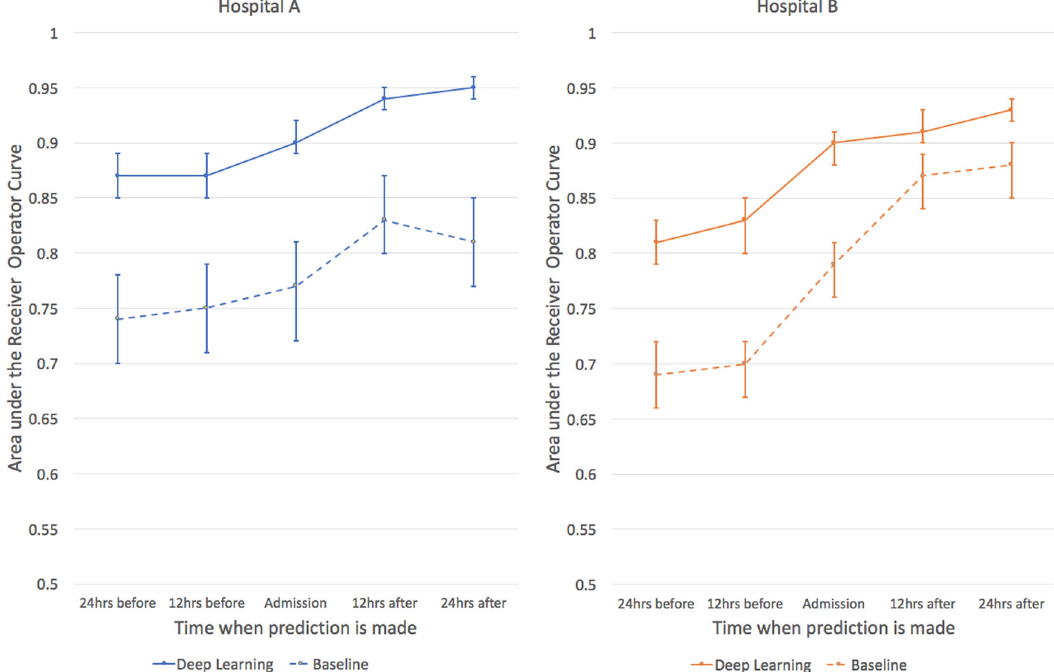
Fig. 2 The area under the receiver operating characteristic curves are shown for predictions of inpatient mortality made by deep learning and baseline models at 12 h increments before and after hospital admission. For inpatient mortality, the deep learning model achieves higher discrimination at every prediction time compared to the baseline for both the University of California, San Francisco (UCSF) and University of Chicago Medicine (UCM) cohorts. Both models improve in the fi rst 24 h, but the deep learning model achieves a similar level of accuracy approximately 24 h earlier for UCM and even 48 h earlier for UCSF. The error bars represent the bootstrapped 95% con fi dence